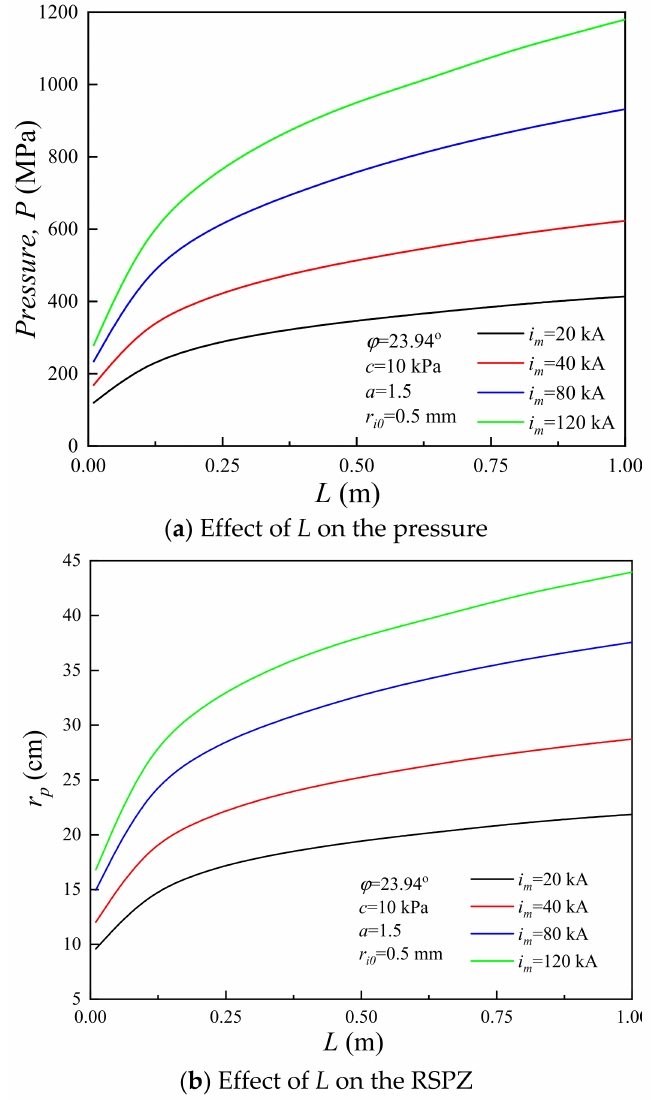
Figure 13. Influence of the plasma channel